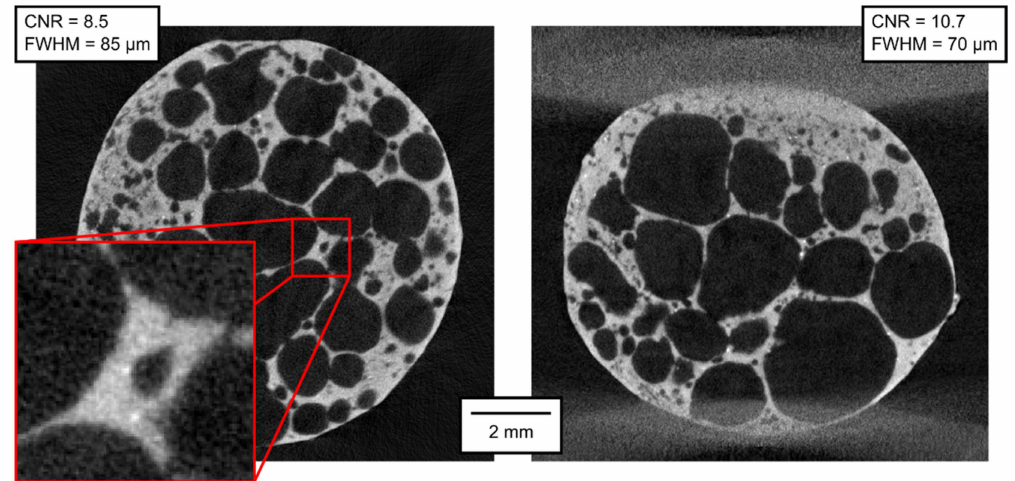
Figure 10. Transversal and lateral central section of the 3D reconstructed volume, Mode D.